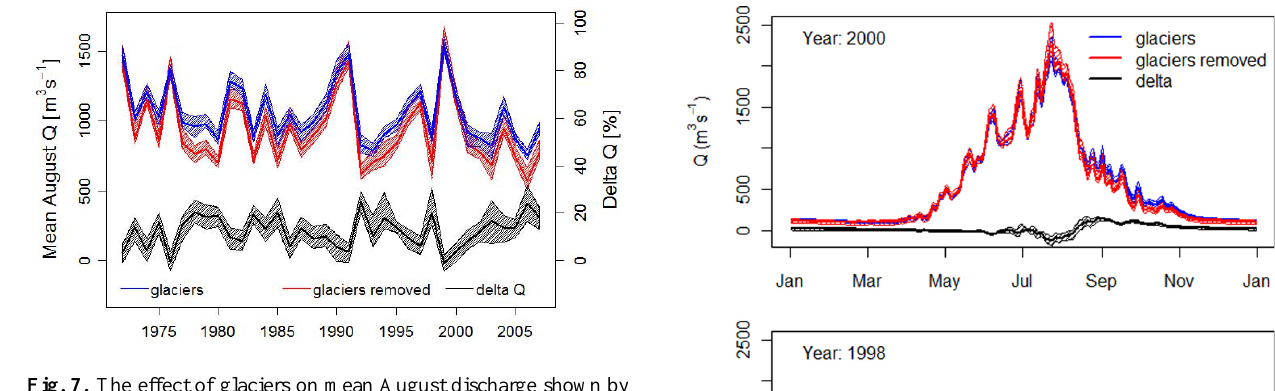
Fig. 7. The effect of glaciers on mean August discharge shown by comparing simulations with and without glaciers including uncer- tainty limits (5–95% quantile range).